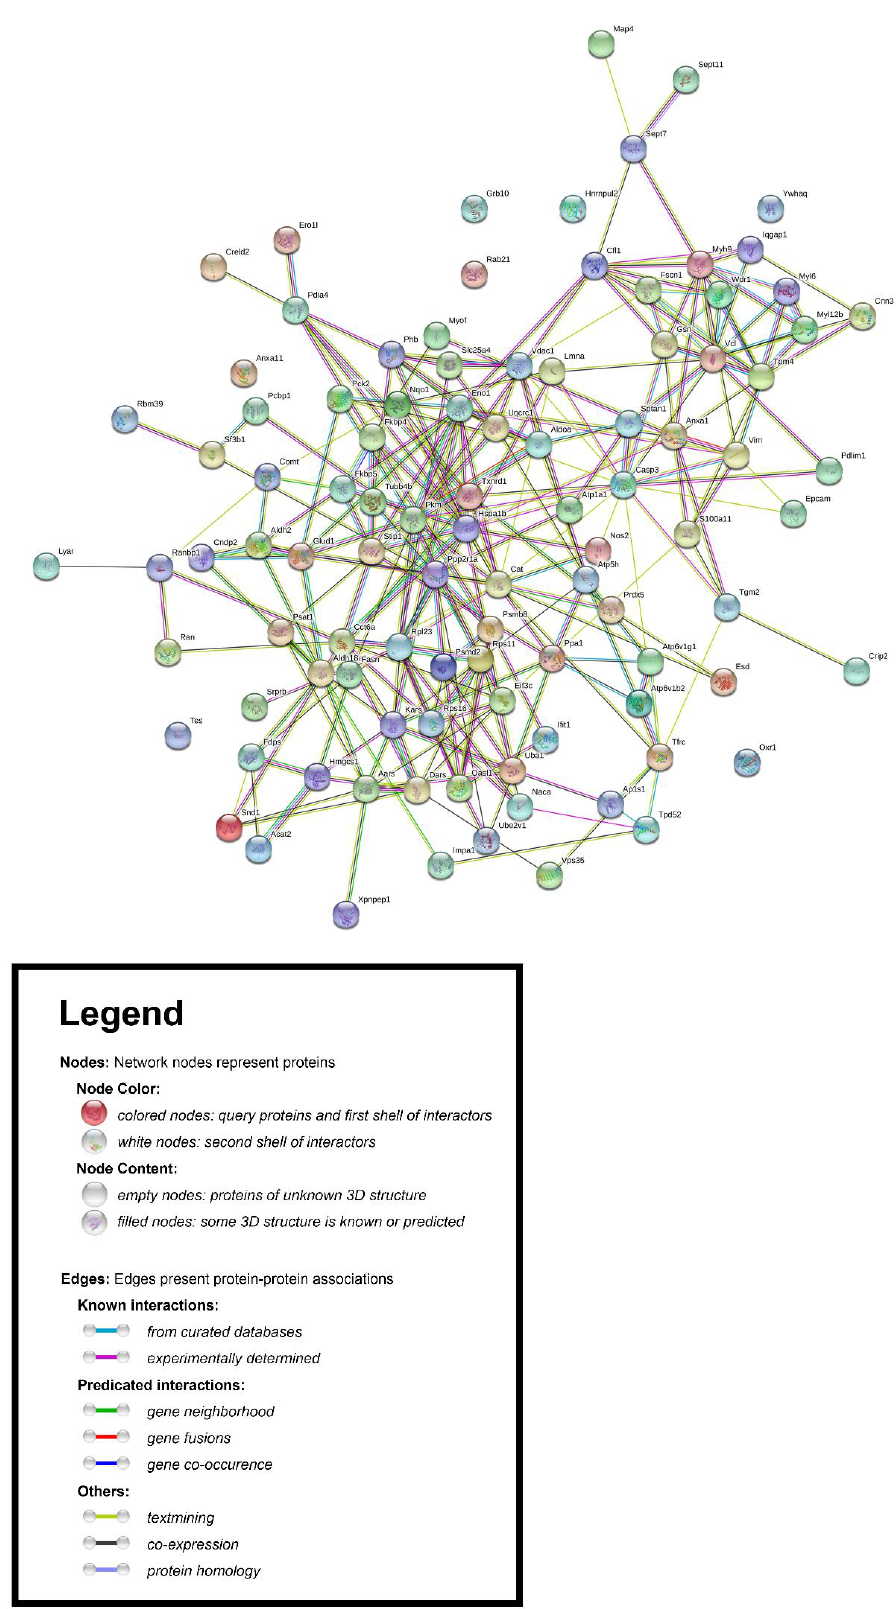
Figure 4. Protein–protein interaction (PPI) network associated with the di ff erentially expressed proteins inPLum-AIvs.PLum-ADcells.TheRetrievalofInteractingGenes / Proteinsdatabase(STRINGv11.0)[34] was used to construct the PPI